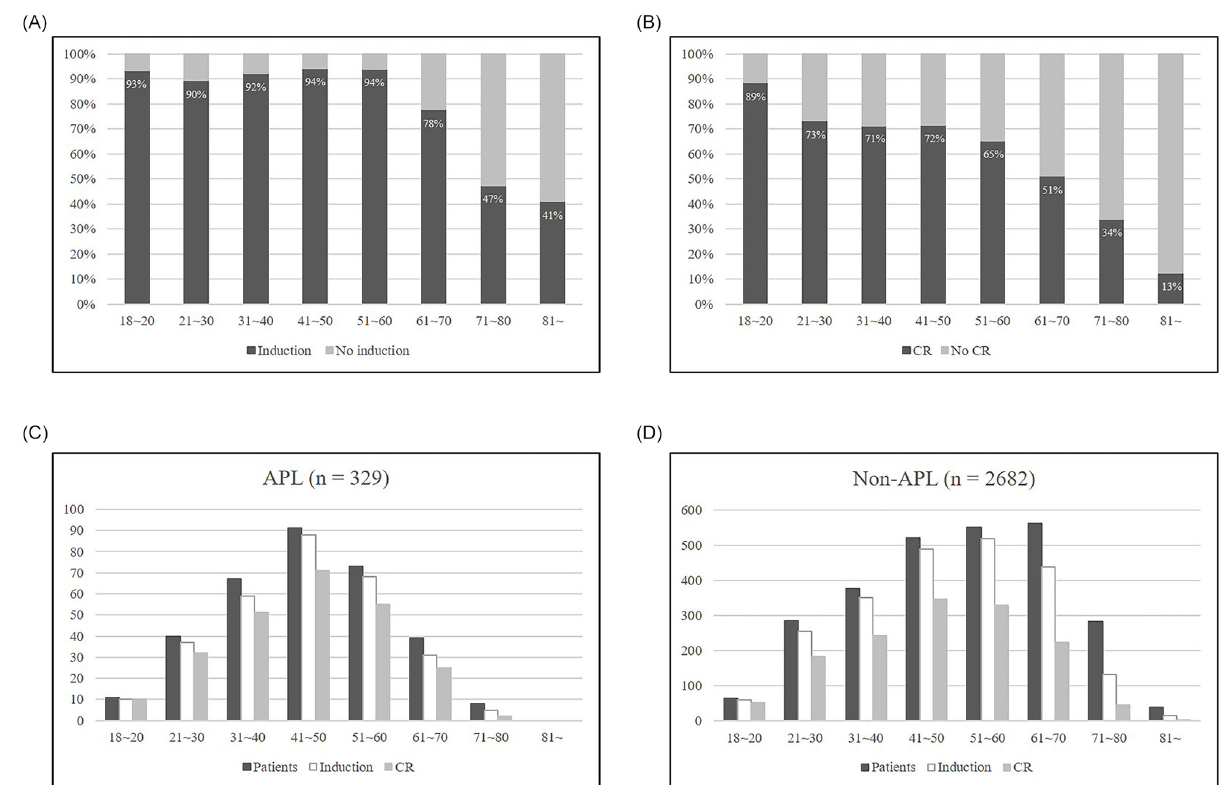
Fig 3. Proportions of patients who received remission induction chemotherapy (A) and who achieved complete remission (CR) (B) by age group (all patients); Acute promyelocytic leukemia (APL) patients (C) and non-APL patients (D) who received remission induction chemotherapy and who achieved CR by age